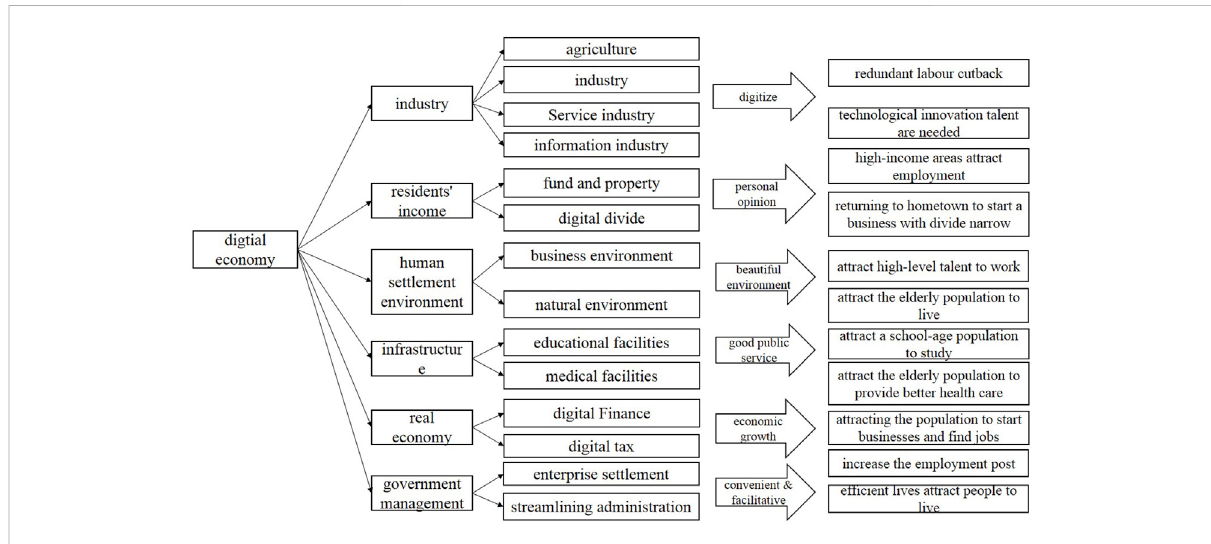
FIGURE 1 Logical diagram of the impact of the digital economy on the